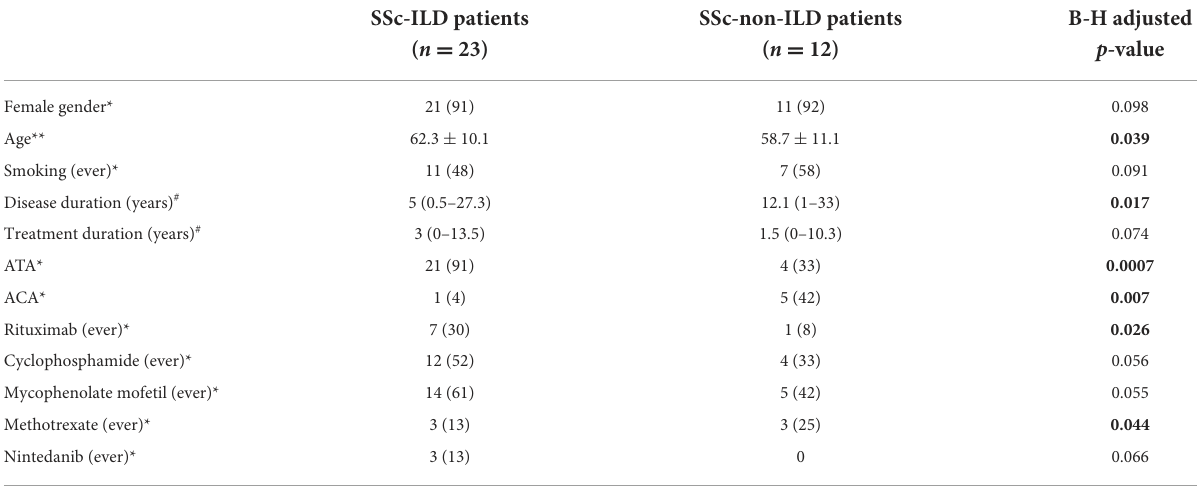
TABLE 3 Demographic, clinical and immunological characteristics of SSc patients with and without